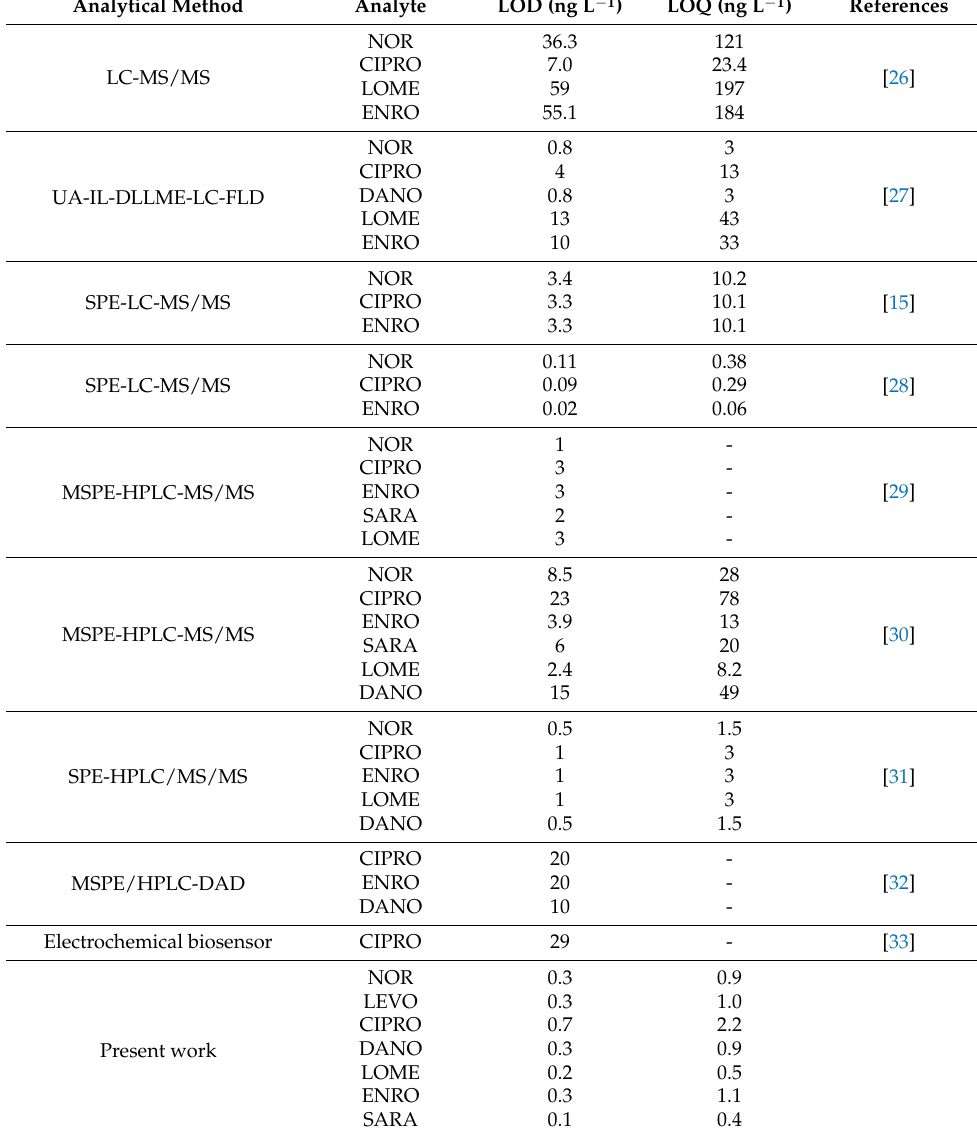
Table 4. Analytical methods for the determination of FQs in water